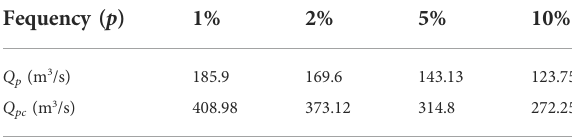
TABLE 2 Calculation value of rainstorm fl ow and debris fl ow. TABLE 3 Slope debris fl ow simulation